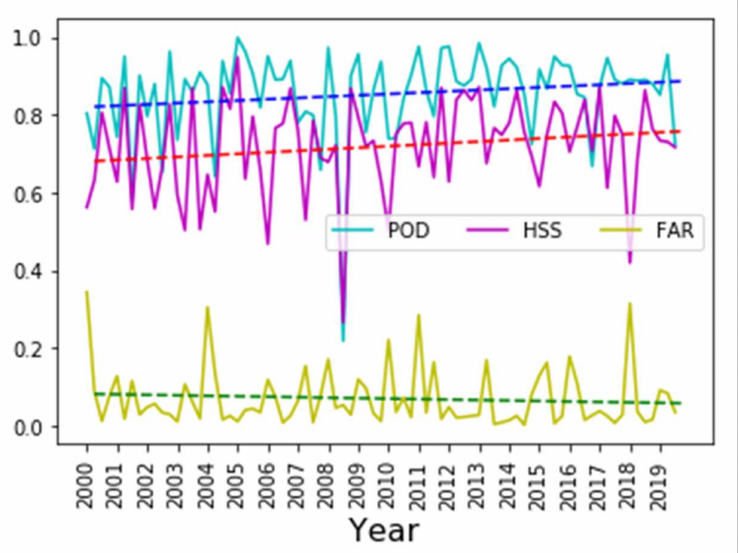
Figure 11. Temporal variations of POD, FAR, and HSS between MODIS CM and our CM from 2000 to